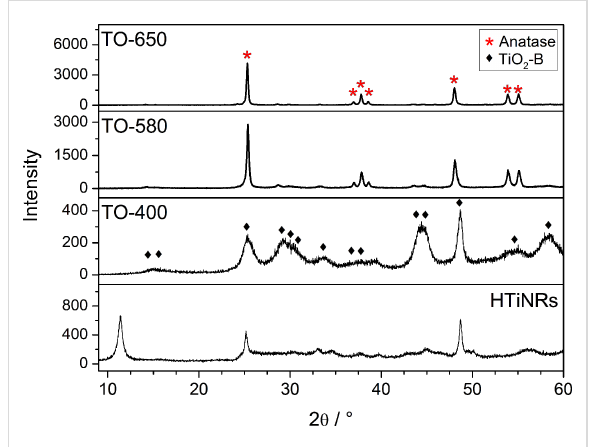
Figure 1: XRD patterns of precursor hydrogen titanate nanoribbons and TiO 2 nanoribbons derived from hydrogen titanate nanoribbons resulting from a heat treatment in air at 400, 580 and 650 °C.